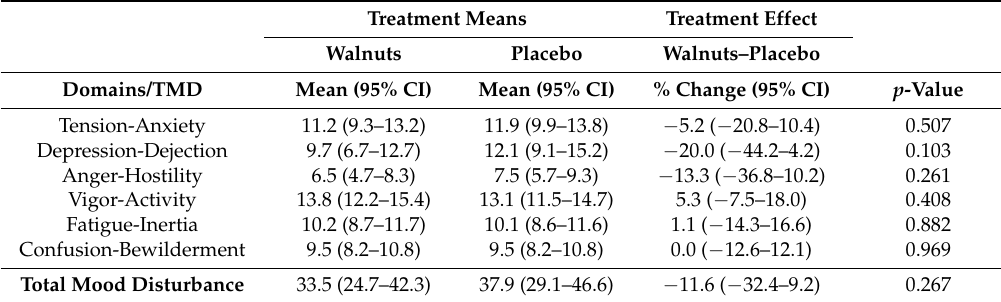
Table 4. Mean scores and changes in Profiles of Mood States (POMS) for both sexes on walnut and placebo diet ( n = 49).